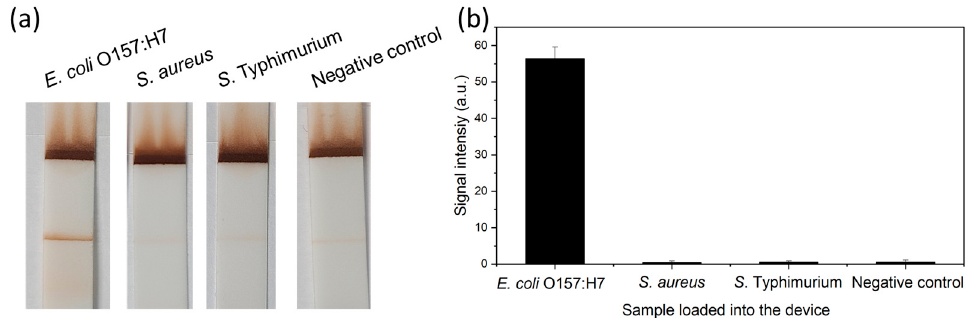
Figure 5. ( a ) Photos of the detection result of different bacteria. ( b ) Bar graph of the detection intensities.